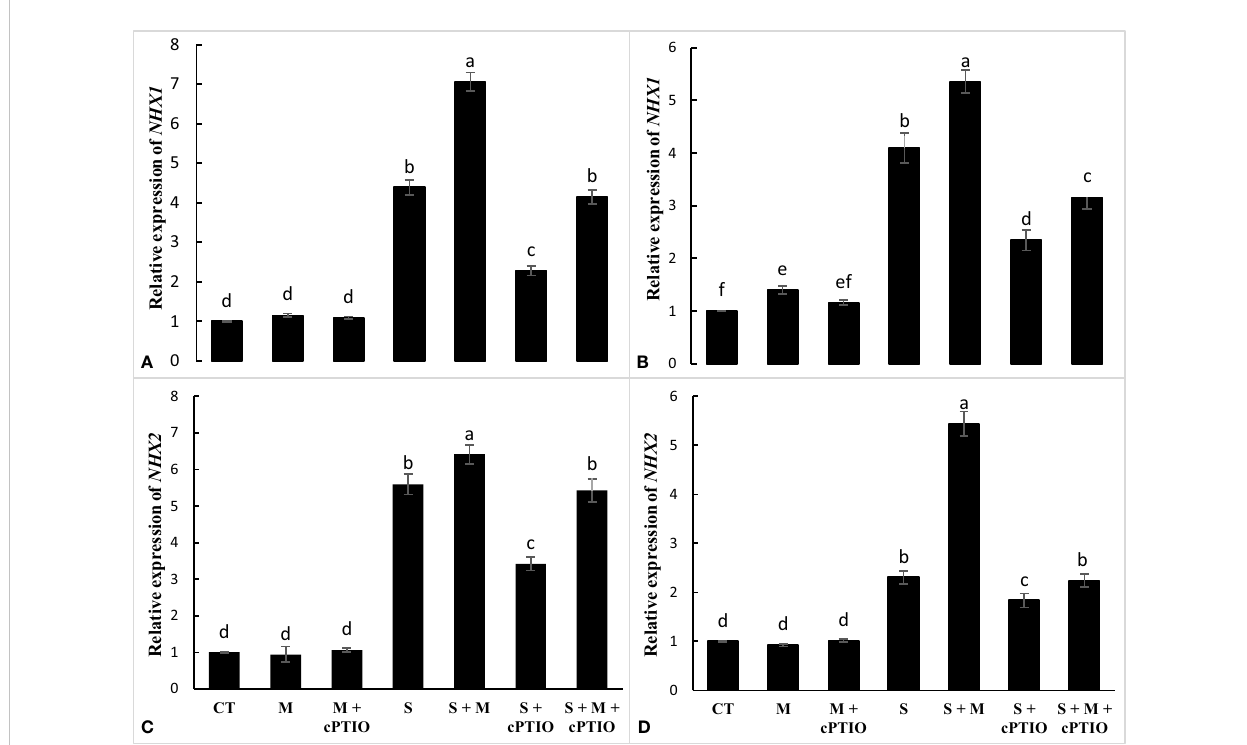
FIGURE 5 The relative expression of NHX1 and NHX2 genes in the root (A, C) and leaf (B, D) of tomato seedlings treated with melatonin (150 m M) and cPTIO (100 m M) under NaCl (150 mM) treatment. Different letters in each column show signi fi cant differences at the p < 0.05 based on the LSD test (means ± SD, n = 3), CT, control treatment; M, melatonin; S, salinity.